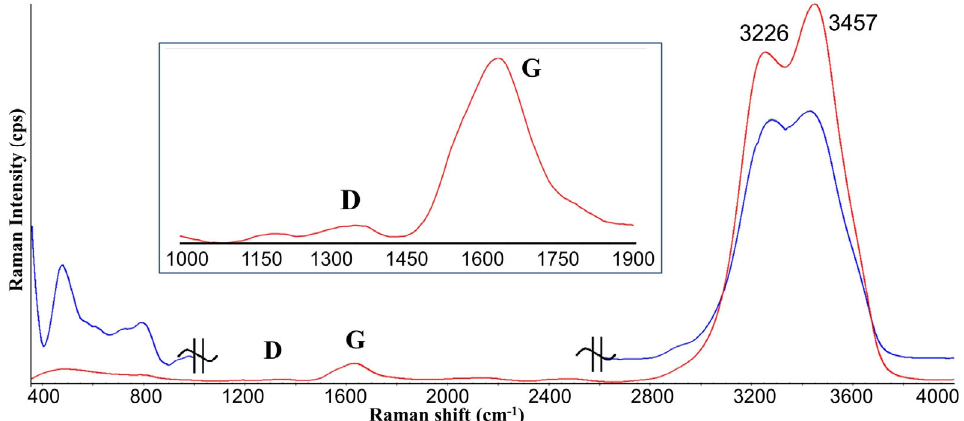
Figure 1. Raman spectra of shungite carbon (ShC) nanoparticles in aqueous dispersion (red) and quartz (Qz) nanoparticles in aqueous dispersion (blue). Nanoparticles content 0.12 mg/mL. Insertion: the first order region of Raman spectrum with the typical D and G bands of carbon materials. ID/IG—0.04. (The signal intensities of the Raman spectra of Qz NPs dispersion in the region 400–1000 cm − 1 was increased ten-fold to guide the eyes).